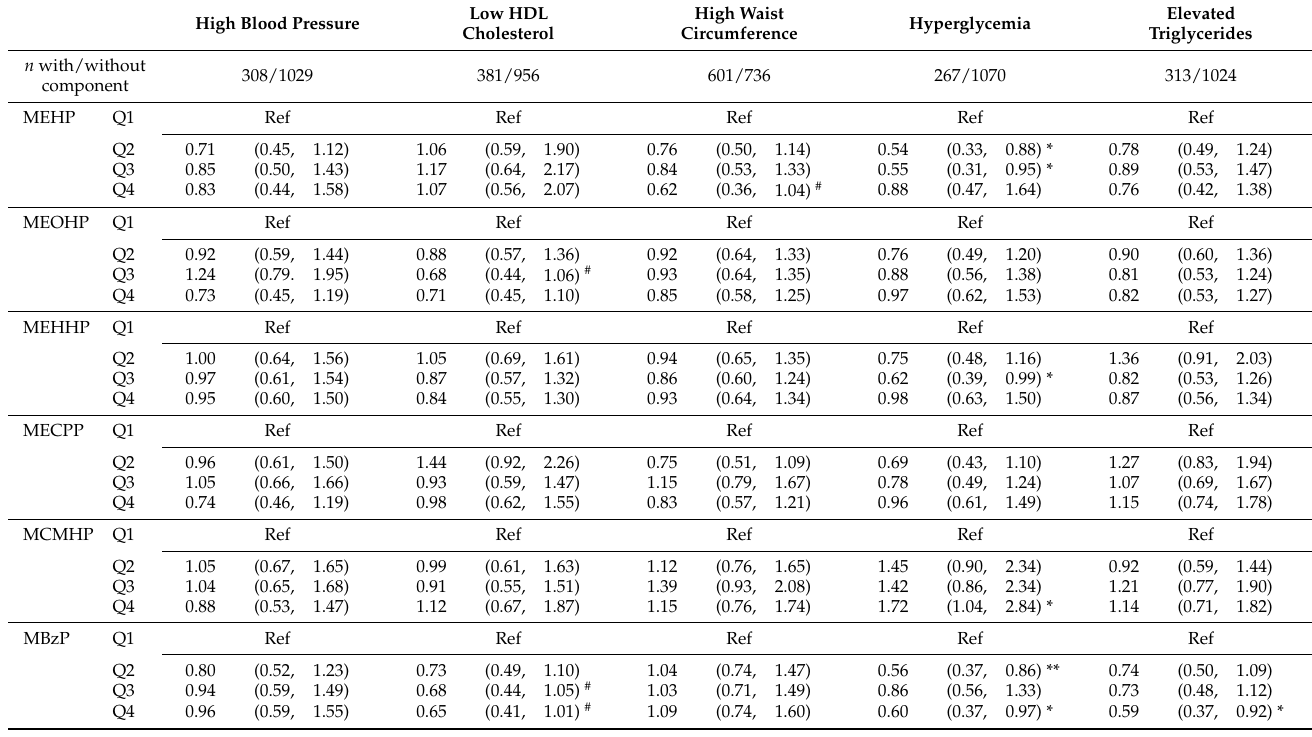
Table 4. Prevalence odds ratios and 95% confidence intervals for individual MetS components for each quartile of urinary phthalate metabolite